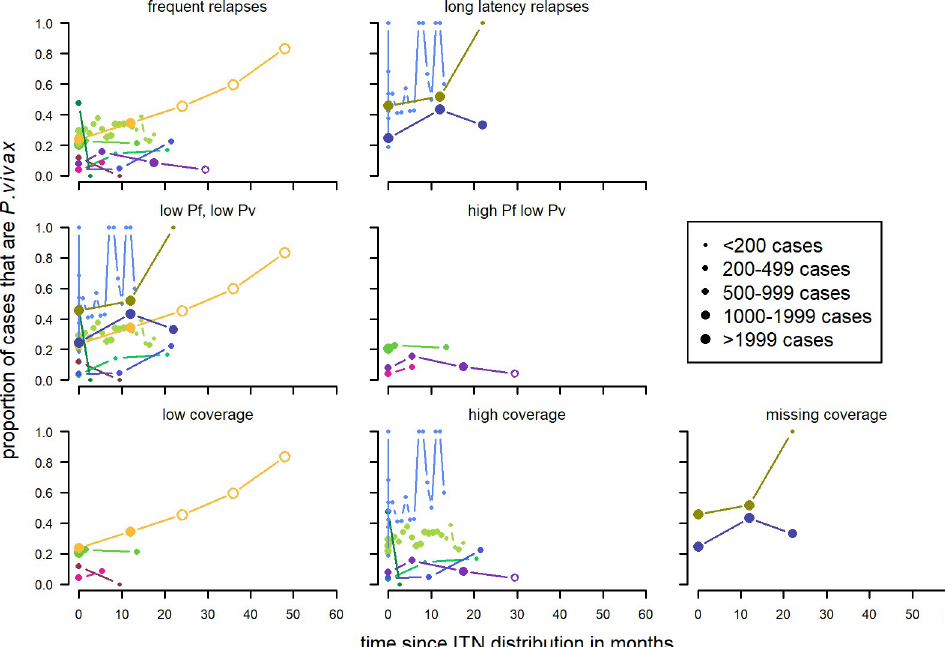
Fig 10. Spaghetti plots splitting the series of time-points of the proportion of cases with P. vivax infection by relapse pattern, transmission intensity and coverage after repeated ITN distribution. Excluding series of time points that have no measurement within 24 months after the intervention. Dot size depending on number of infections.